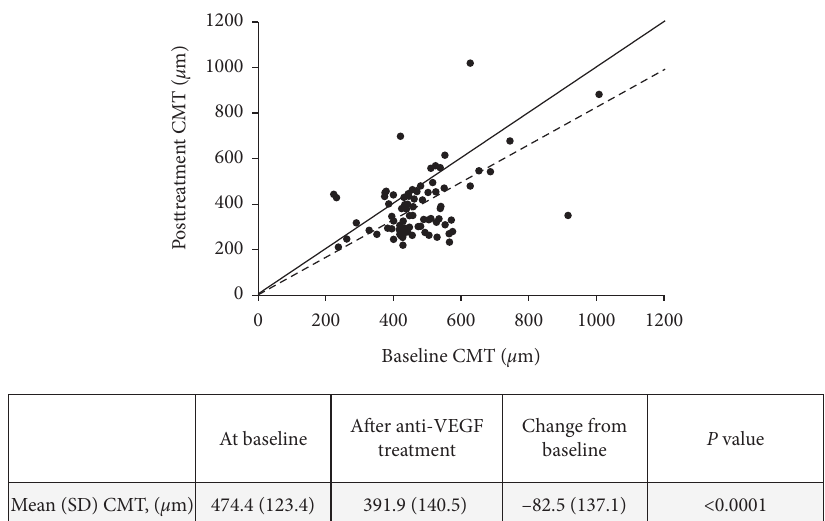
Figure 3: Central macular thickness at baseline and after 5 anti-VEGF injections. Notes: the solid line represents the 45-degree line, and the dashed line represents a 20% change from the 45-degree line following